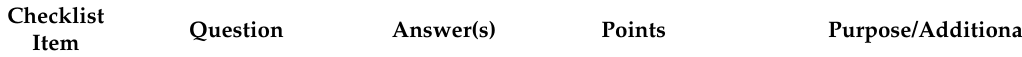
Table 5. Questions from the “Bedroom” checklist